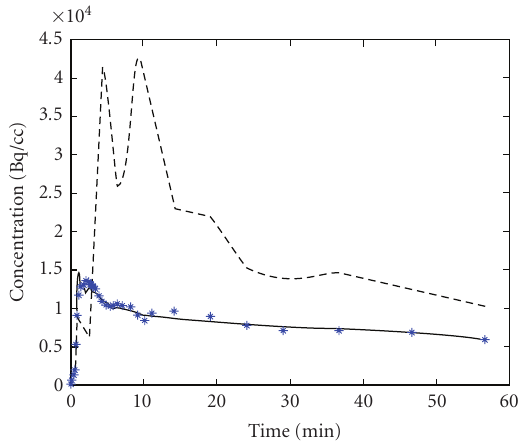
Figure 4: Time-activity curve. The normal line represents the time- activity curve of renal parenchyma, the dashed line is the time- activity curve of renal pelvis, and the asterisks show the point we